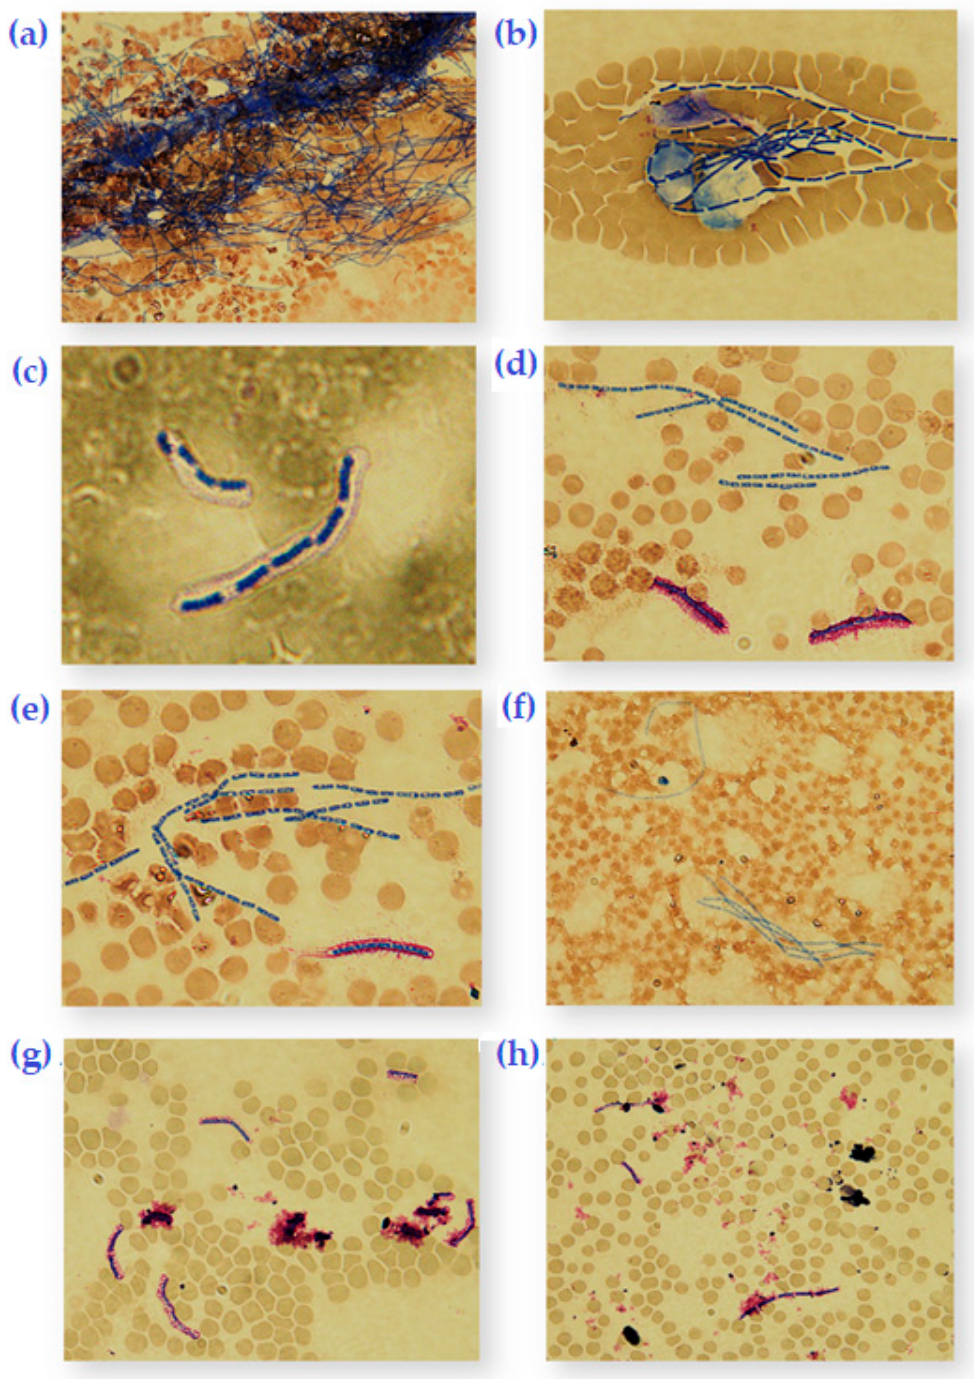
Figure 2. Romanowski-Giemsa-stained blood smears of Bacillus anthracis at 1000x magnification. ( a ) Unencapsulated B. anthracis Sterne vaccine strain at 12 h of 37 °C incubation. ( b ) Sterne with γ -phage at 8 h of 37 °C incubation. ( c ) B. anthracis DS201579 showing encapsulation (balloon-like layer) at 8 h of 37 °C incubation. ( d ) DS201579 with NaHCO 3 in 8% CO 2 at 8 h of 37 °C incubation showing thickened capsule (purple) and cells with endospores (blue). ( e ) DS201579 at 37 °C incubation for 12 h in 8% CO 2 where all cells contain endospores (blue) and degradation of mother cell has begun (purple streaks). ( f ) DS201579 with NaHCO 3 and 8% CO 2 at 37 °C incubation for 12 h of showing 100% sporulation. ( g ) DS201579 with Bacillus phage Crookii at 37 °C incubation for 12 h and 8% CO 2 of showing lysed cells as well as intact endospores. ( h ) DS201579 with Bacillus phage Crookii at 37 °C incubation for 12 h where all vegetative cells in view were lysed.